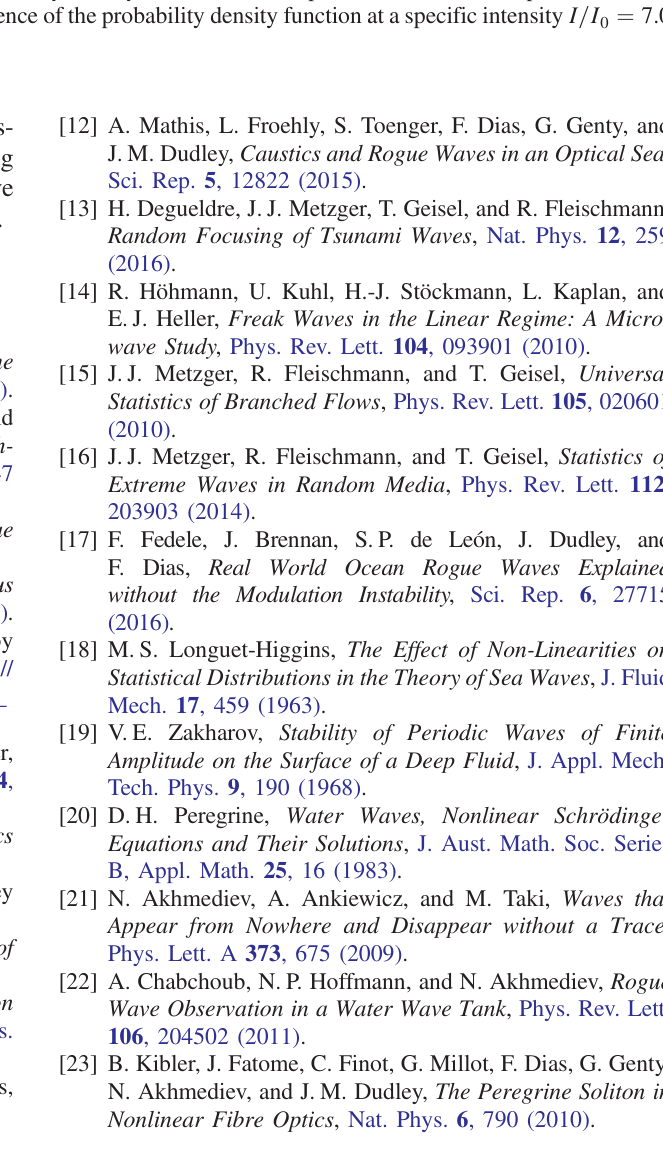
ˆ S is multiplied. Hence, it affects each ffiffiffi p a ¼